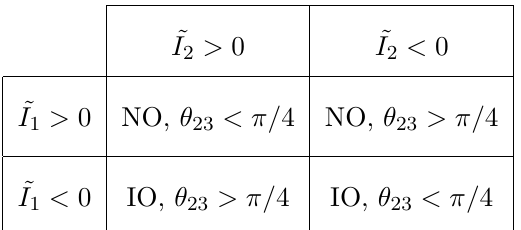
Table 2 . Combination of the two invariants. NO stands for normal ordering, IO for inverted